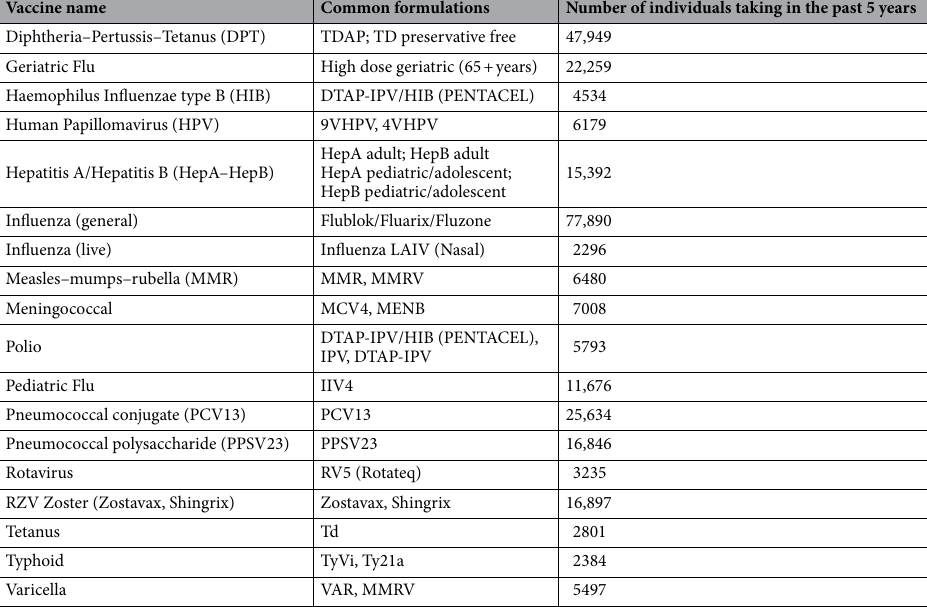
Table 2. Summary of vaccines and common formulations. The 18 vaccines taken by at least 1000 individuals within 5 years prior to their PCR test date, along with the most common formulations and patient counts. Note that some common formulations are combinations of multiple vaccines (e.g. Pentacel is a combination of DPT, polio, and HIB vaccines).